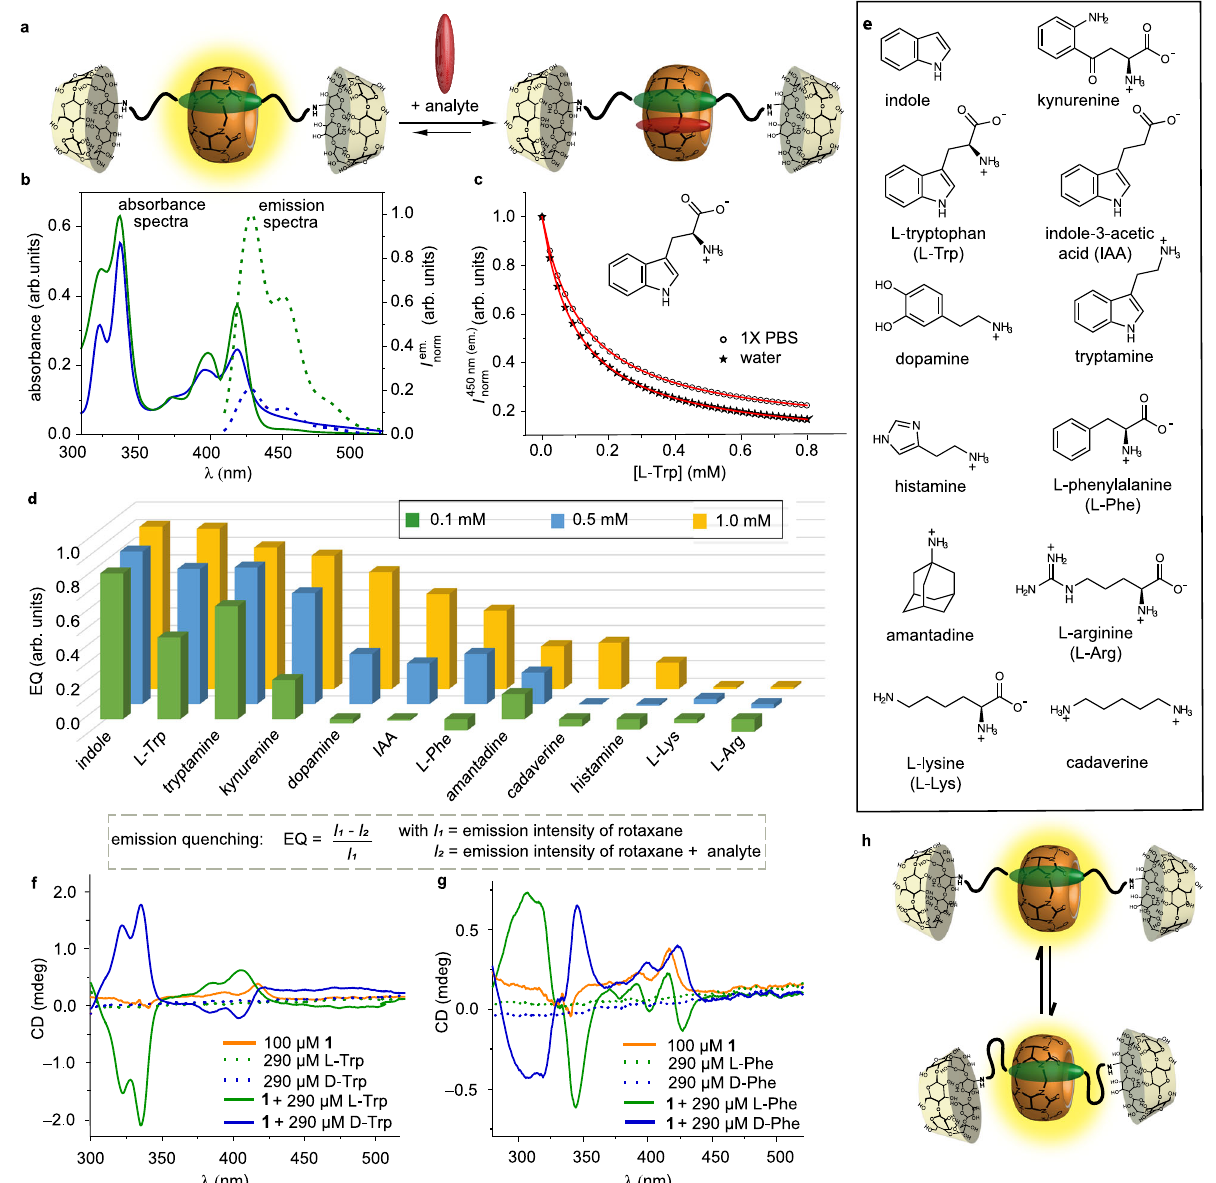
Fig. 3 | Host – guest binding with rotaxane 1. a Schematic representation of ana- lyte binding by rotaxane 1 . b Absorbance (solid line) and normalized emission (dottedline)spectraofrotaxane 1 intheabsence(green)andpresenceofTrp(blue) inwaterwith λ ex =393nm. c Bindingisothermsofrotaxane 1 ( c =2.5 µ M)andTrpin either water (stars) or 1X PBS (empty dots) and the corresponding fi t (red line) of the obtained data ( λ ex =393nm, λ em =450nm), measured in at least n =3 inde- pendent replicates. d Emission quenching of rotaxane 1 ( c =1.0 µ M) upon adding 0.1mM (green), 0.5mM (blue), and 1.0mM (yellow) of bioactive analyte in 1X PBS ( λ ex =393nm, λ em =450nm), measured in at least n =4 independent